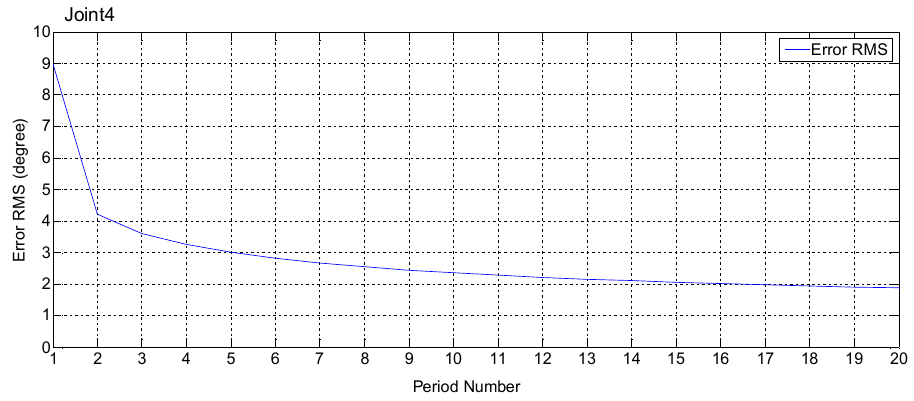
Figure 12. RMSE convergence curve based on LMS-PID tracking control.